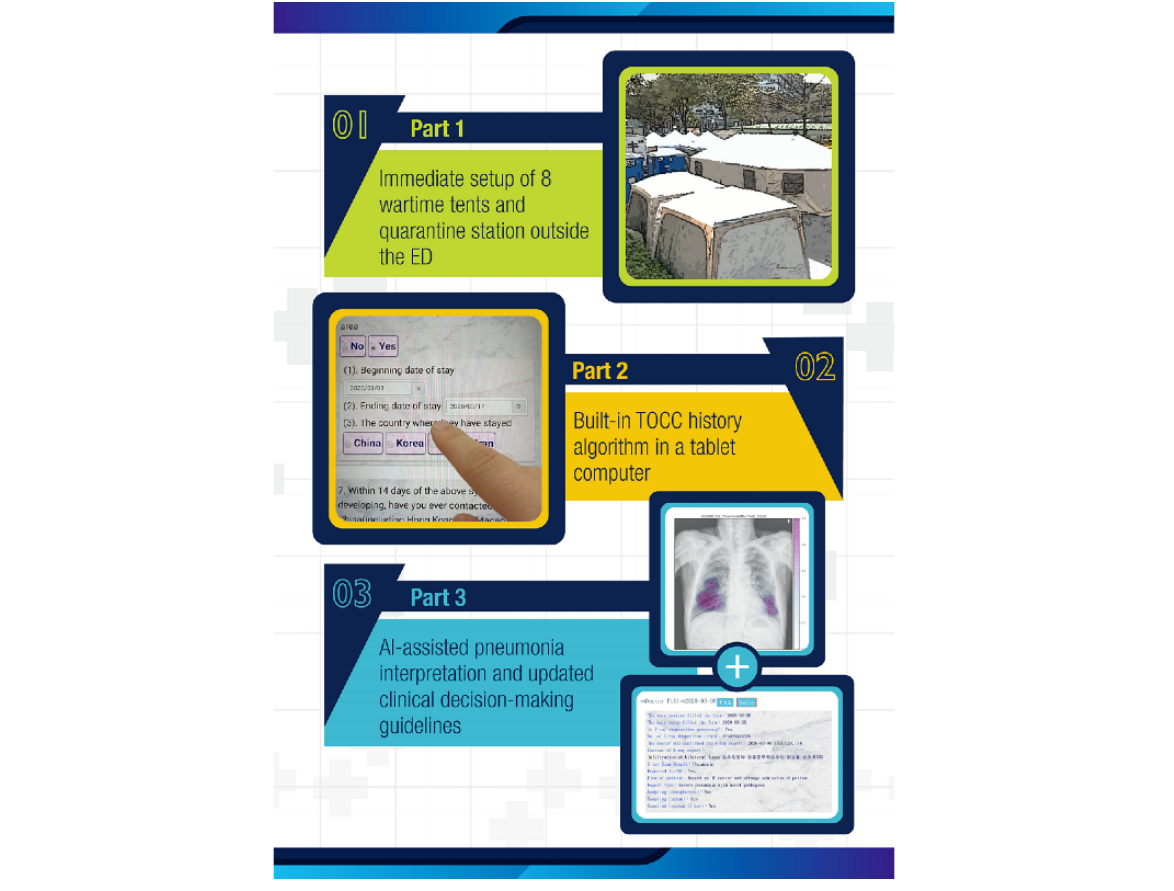
Figure 4. Synergetic combination of quarantine station establishment, smart patient processing, and AI to improve the efficiency and safety of patient processing during the COVID-19 pandemic. ED: emergency department; TOCC: travel, occupation, contact, and